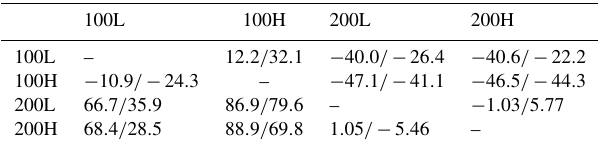
Table 3. Output of sediment during each experiment, from the time sediment output occurred. The proportion of sediment output is rel- ative to the volume input over the same time span.